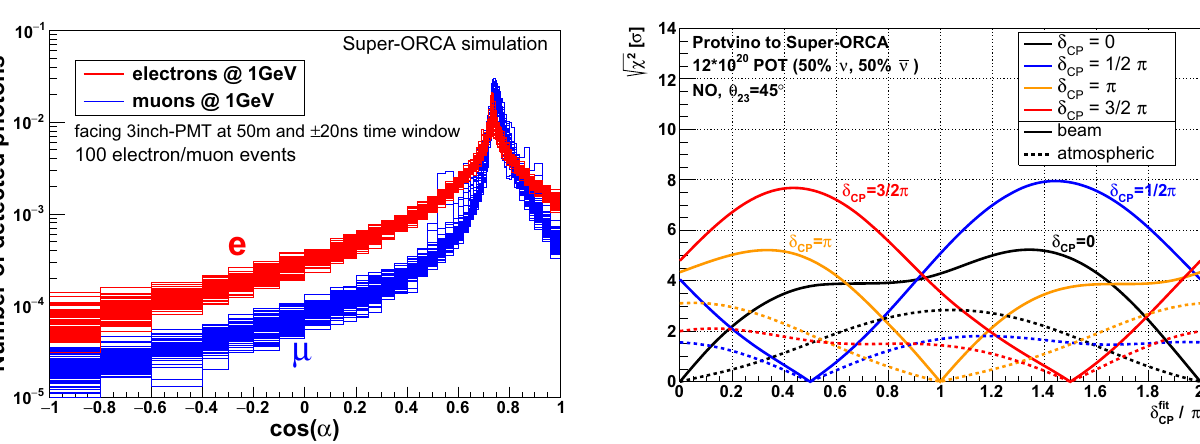
Fig. 12 Angular profile of the Cherenkov light recorded 50m away from simulated 1GeV electrons and muons. Each line shows one out of 100 different simulated electron and muon events. The number of detected photons per 3-inch PMT pointing towards the simulated parti- cle as a function of the cosine of the angle α between the initial particle direction and the vector from the PMT to the particle position is shown. The particle position is defined as the barycentre of all Cherenkov pho- ton emission positions. A ± 20ns integration time window around the average expected photon arrival time is used. Occasional outliers for muons are caused by large-angle scattering